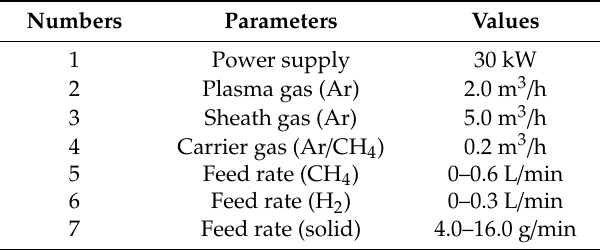
Table 1. Typical processing parameters for RF thermal plasma in our laboratory.